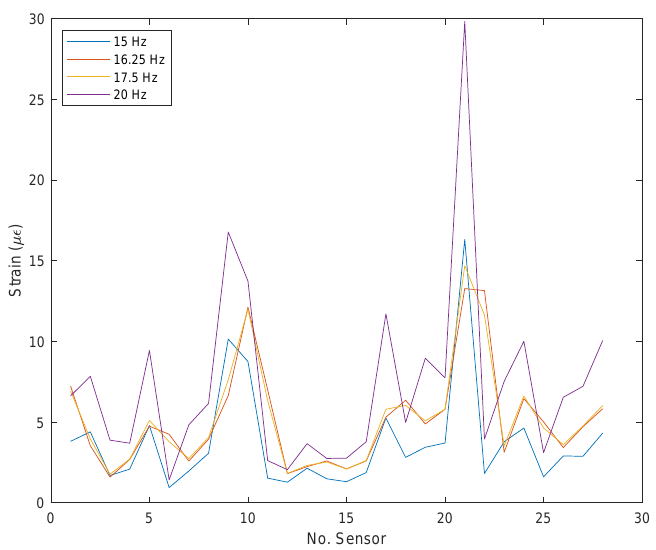
Figure 8. Strains for pristine condition versus sensor number (FBG number) for all excitation frequencies.